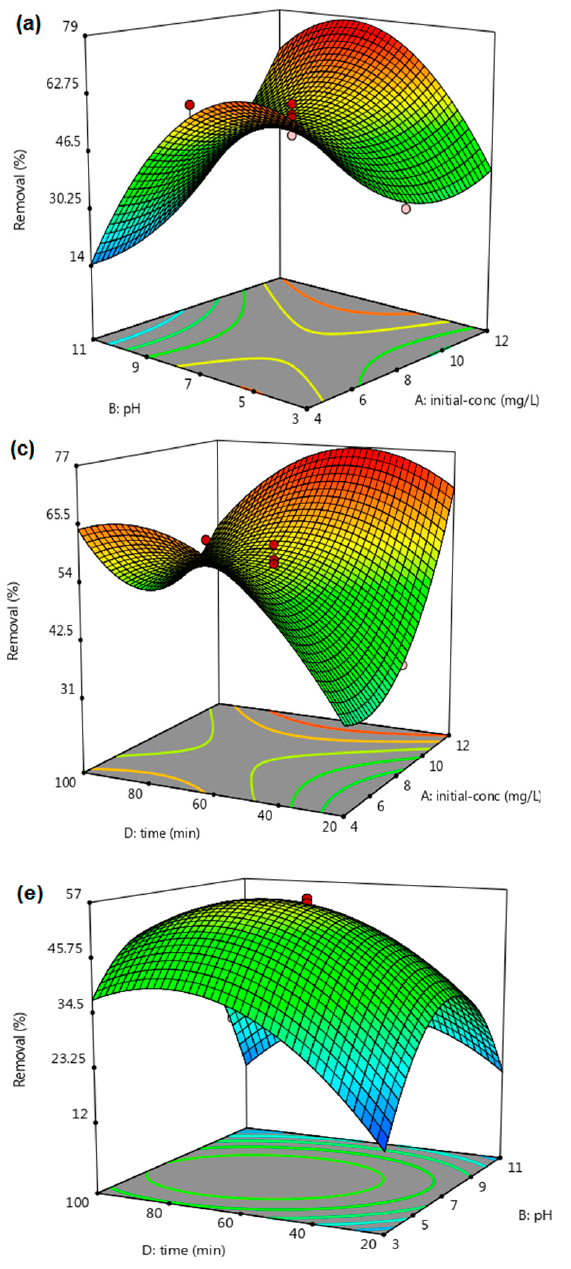
Figure 5. Pareto chart analysis for ( a ) SC and ( b ) PG.